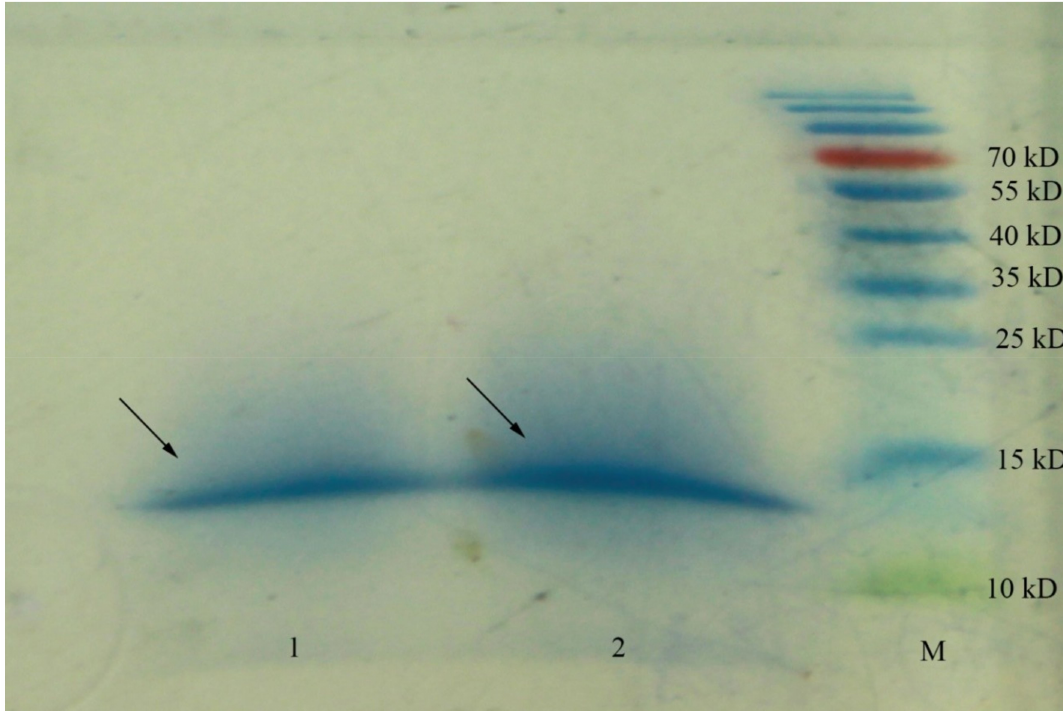
Figure 1. SDS-PAGE gel of Lapsang souchon (LS) extracts obtained from 1kDa membrane. Peptides were revealed using the colloidal Coomassie blue stain. The experiment performed in duplicate was numbered 1, 2. The bands labeled with arrows were used to perform LC-MS/MS analysis. M: molecular mass